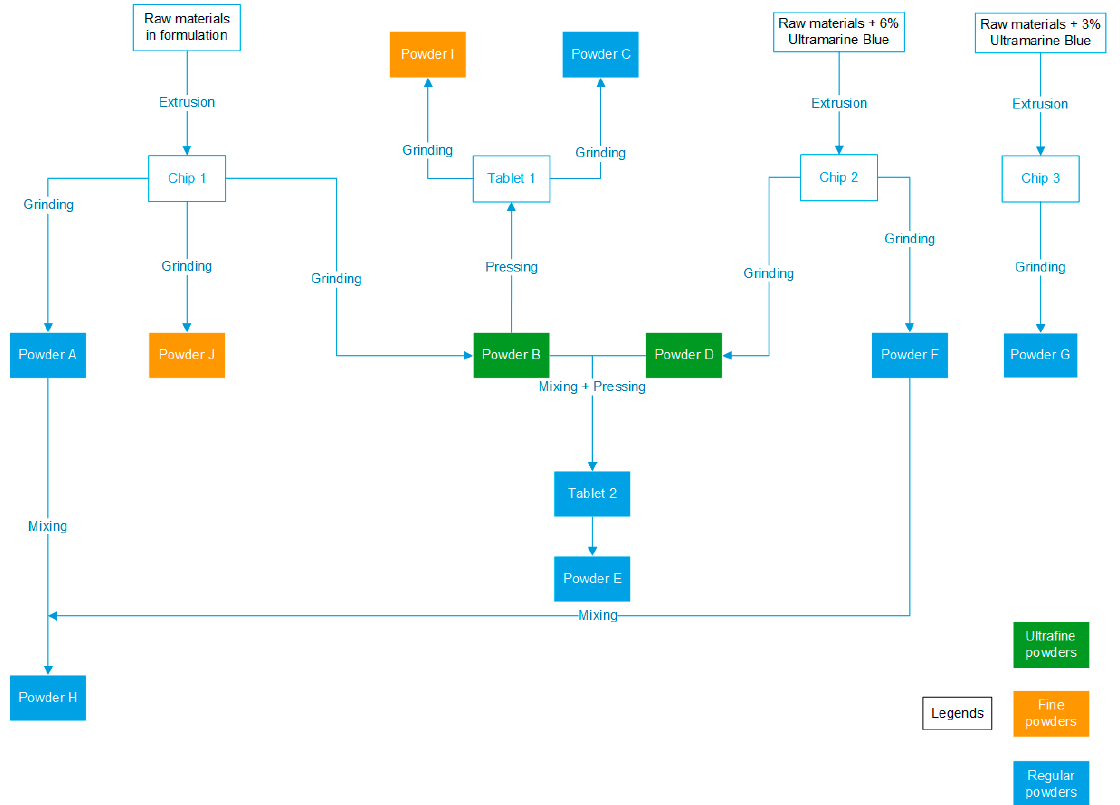
Figure 1. A flowchart of the sample preparation procedure.